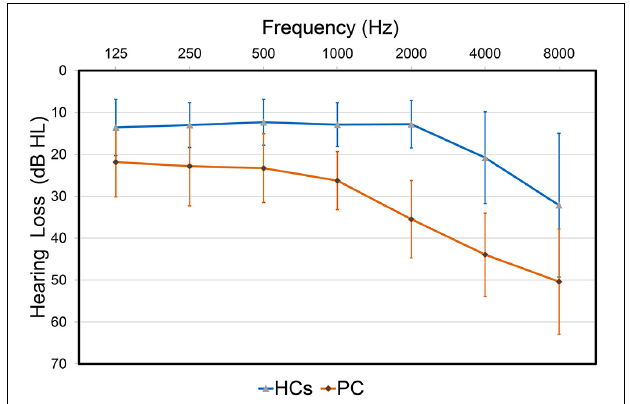
FIGURE 1 | Hearing thresholds of the presbycusis (PC) and healthy controls (HCs) groups (means ± standard deviation) in air conduction. Hearing thresholds from both ears are averaged.